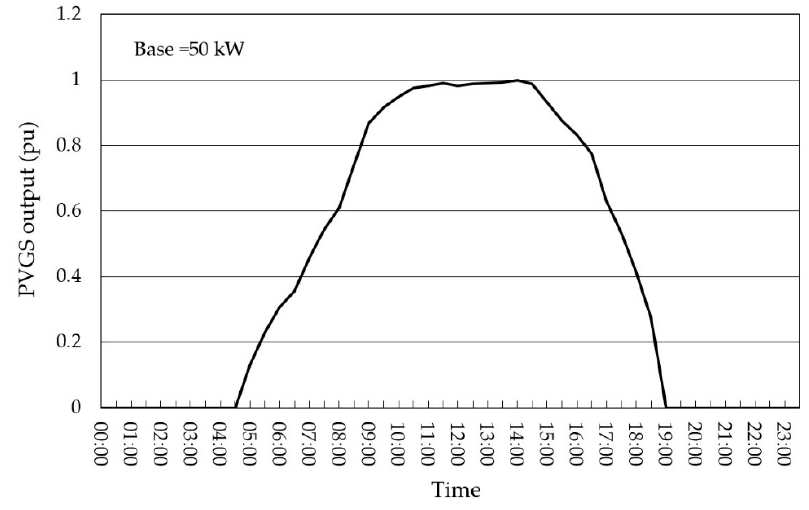
Figure 12. The normalized power curve of a 50-kW solar panel.